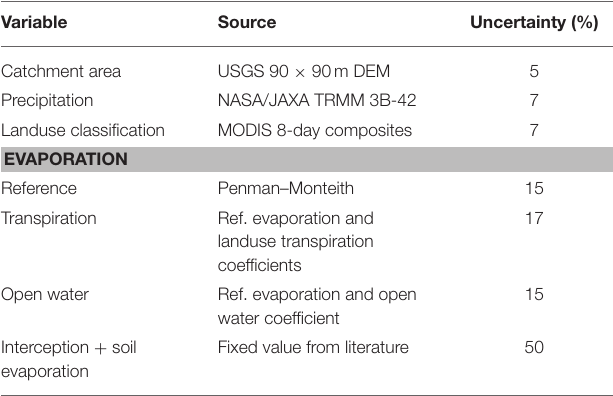
TABLE 1 | Data sources used for the water balance and the rainfall-runoff model. Variable